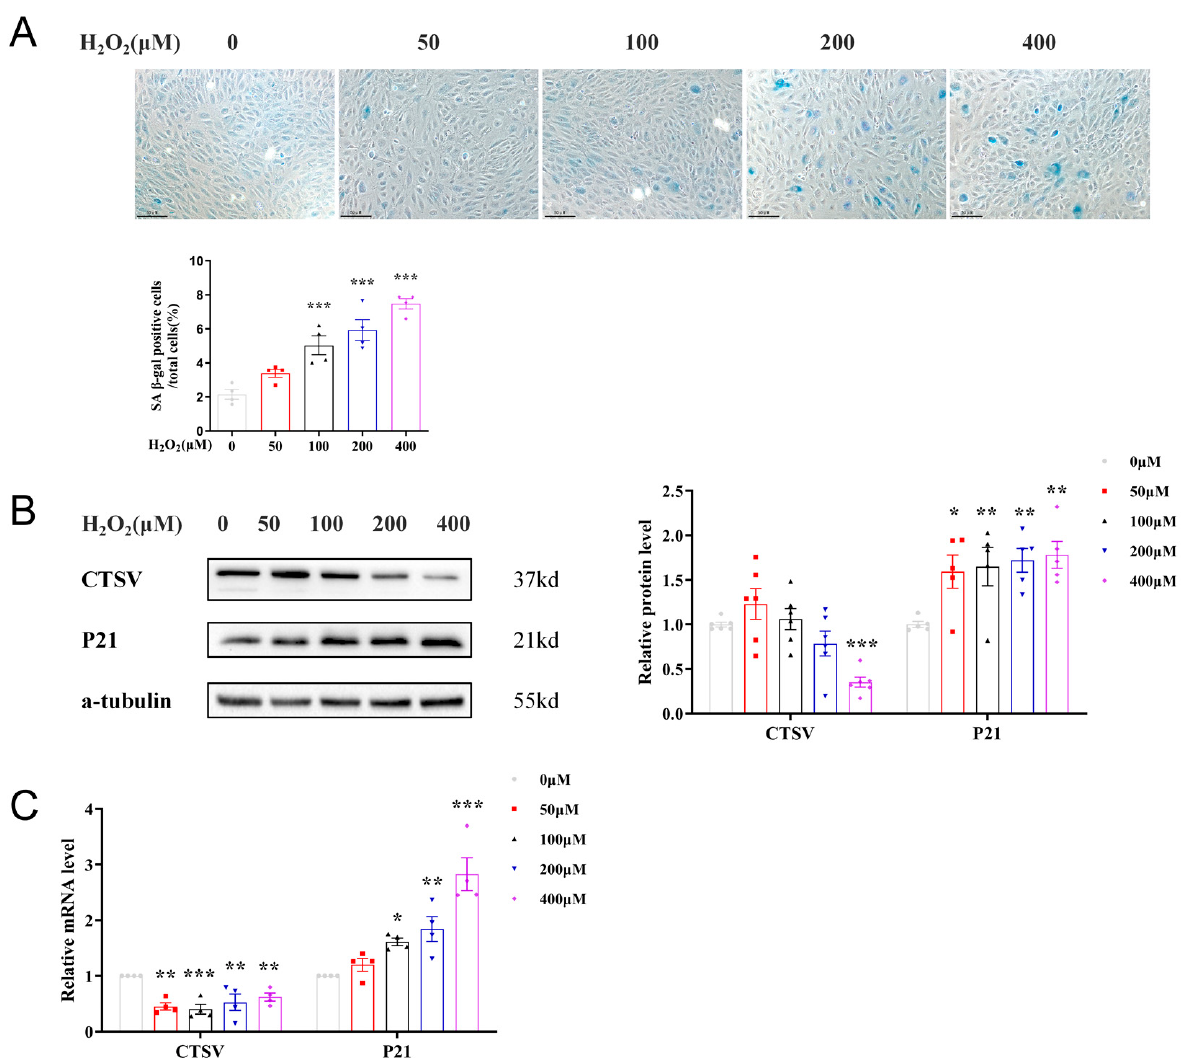
Figure 2. CTSV expression is decreased in H 2 O 2 -induced cellular senescence. ( A ) HUVECs were treated with different dose of H 2 O 2 (0 μ M, 50 μ M, 100 μ M, 200 μ M, and 400 μ M) for 24 h, SA- β -gal activity was analyzed (blue staining for the senescent cells, scale bar = 50 μ m, n = 4). ( B ) Western blot of CTSV and P21 in HUVECs treated with different dose of H 2 O 2 ( n = 5–6). ( C ) Relative mRNA level of CTSV and P21 in H 2 O 2 -treated HUVECs ( n = 4). Data are presented as mean ± SEM. One-way ANOVA test was used. * p < 0.05 vs. 0 μ M, ** p < 0.01 vs. 0 μ M, *** p < 0.001 vs. 0 μ M.